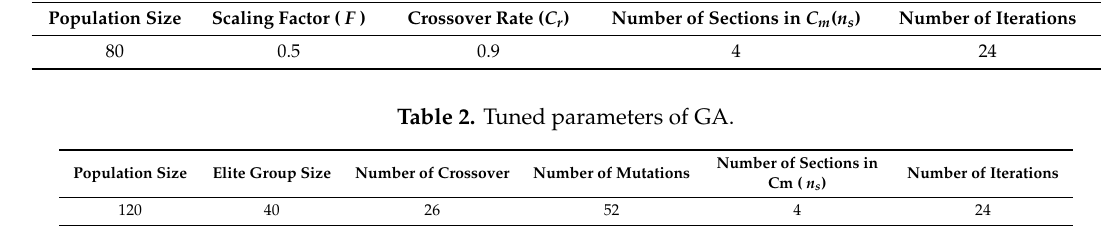
Table 1. Tuned parameters of de algorithm.